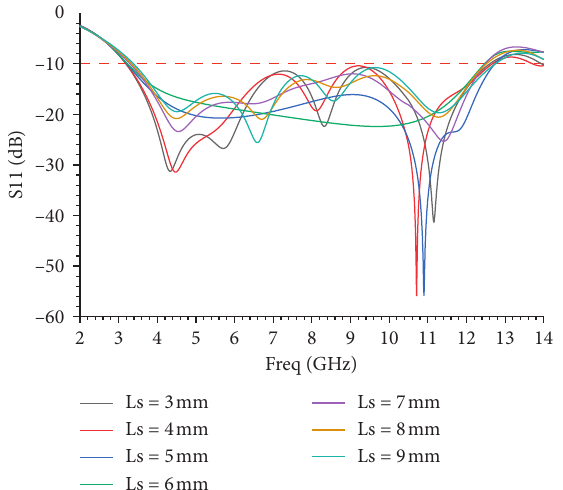
Figure 6: Effect of L s variation on the reflection coefficient.